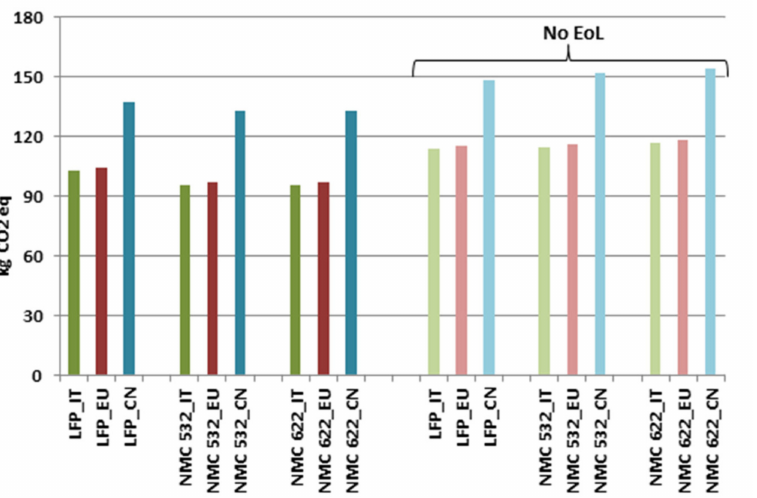
Figure 8. Impact assessment results for the climate change category (kg CO 2 eq) for the different batteries while considering the following energy mixes: Italy (IT), Europe (EU), and China (CN). Data refer to 1 kWh of battery capacity. Battery use phase was not